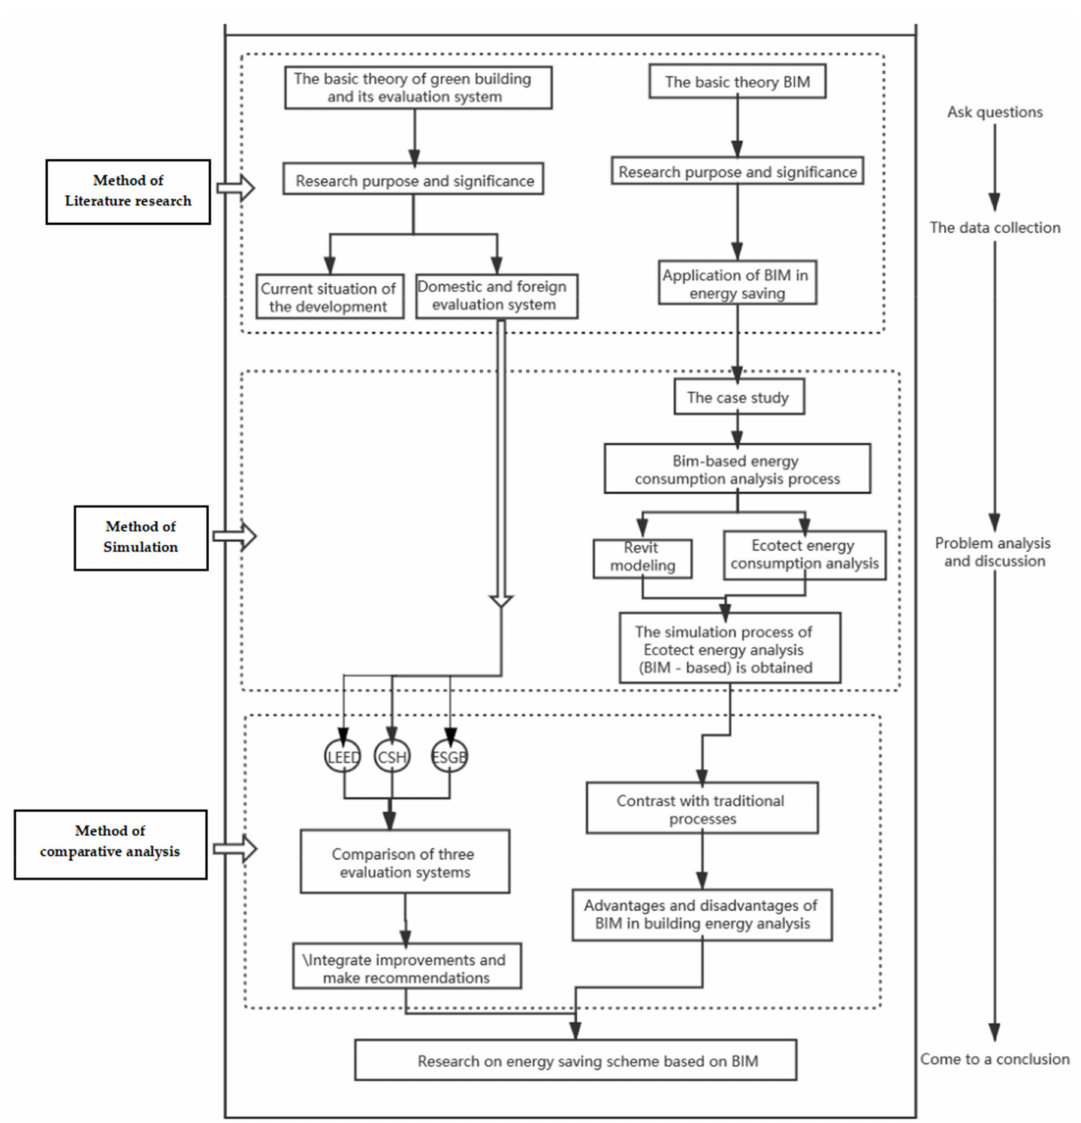
Figure 1. Research